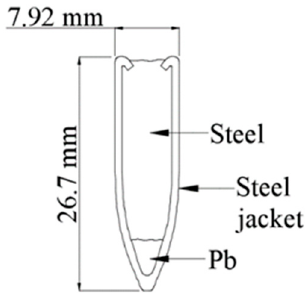
Figure 4. Projectile cut.